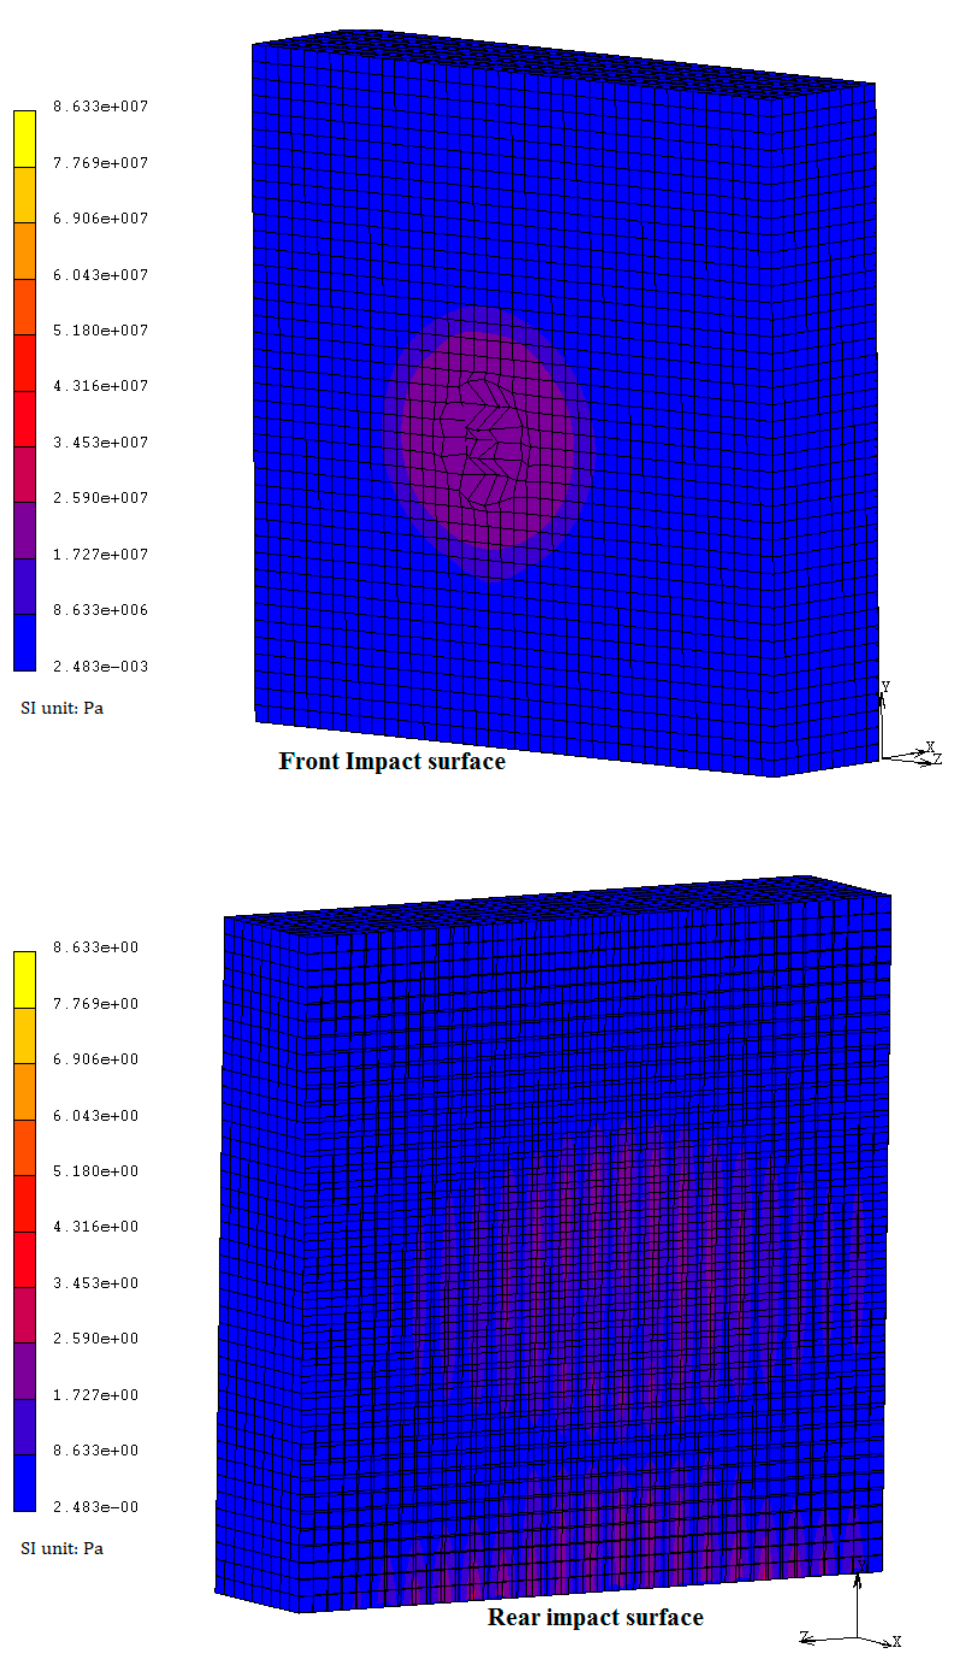
Figure 5. Von Mises stress distribution at 2.1 msec from the impact.